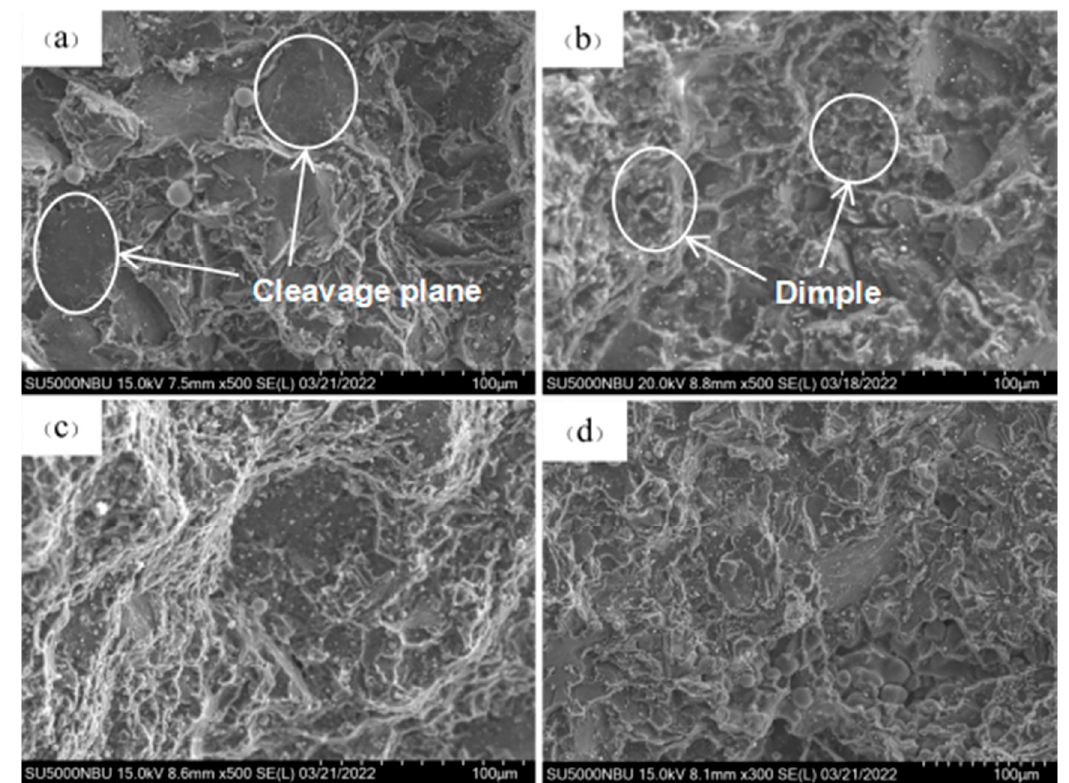
Figure 11. Fracture morphologies of different areas at the injection speeds of 3.5 m/s and 5.0 m/s: ( a ) thin-walled area at 3.5 m/s, ( b ) thin-walled area at 5.0 m/s, ( c ) thick-walled area at 3.5 m/s, ( d ) thick-walled area at 5.0 m/s.